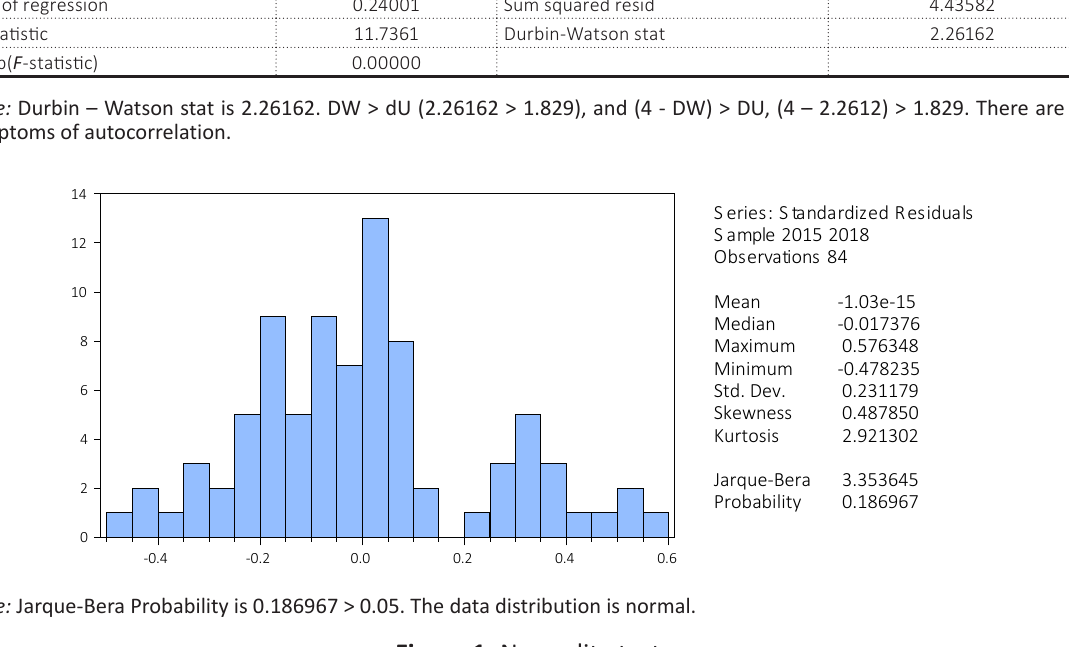
Figure 1. Normality